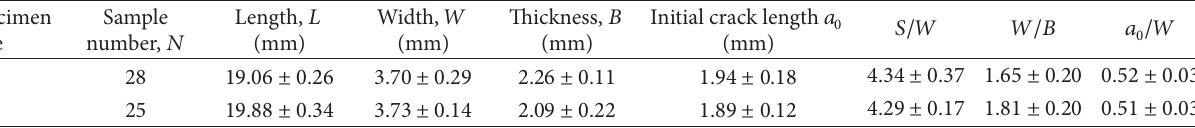
Table 1: Dimension of the prepared specimen. In the table, 𝑆 is the spun length.